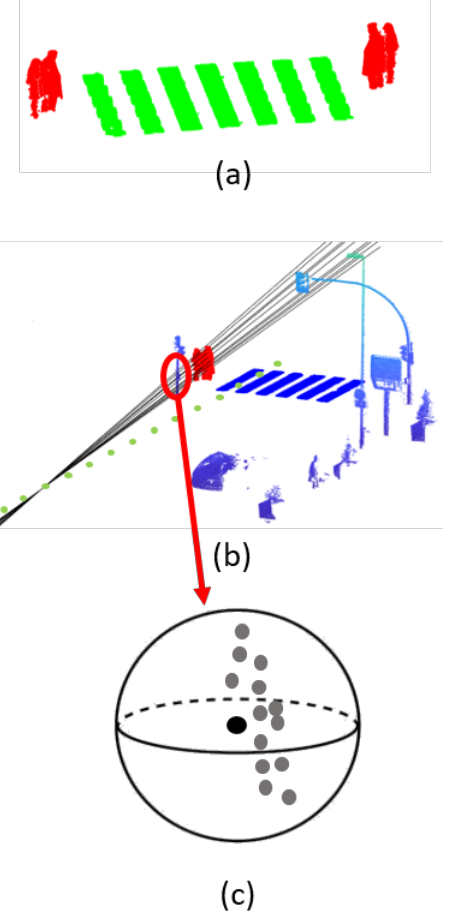
Figure 5. Visibility analysis. (a) Pedestrian templates are located at both sides of the pedestrian crossing. (b) For a PoV of the driver, diferent LoS are defined to analyse the visibility of each point of the pedestrian point cloud. (c) A sphere that slides through each LoS is defined in order to search for occlusions.